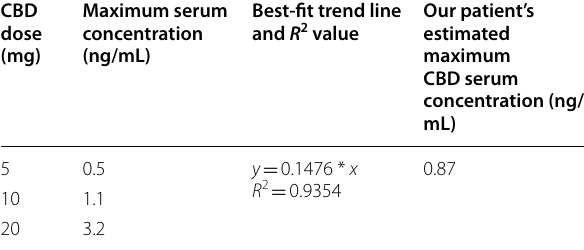
Best-fit trend line and R 2 value